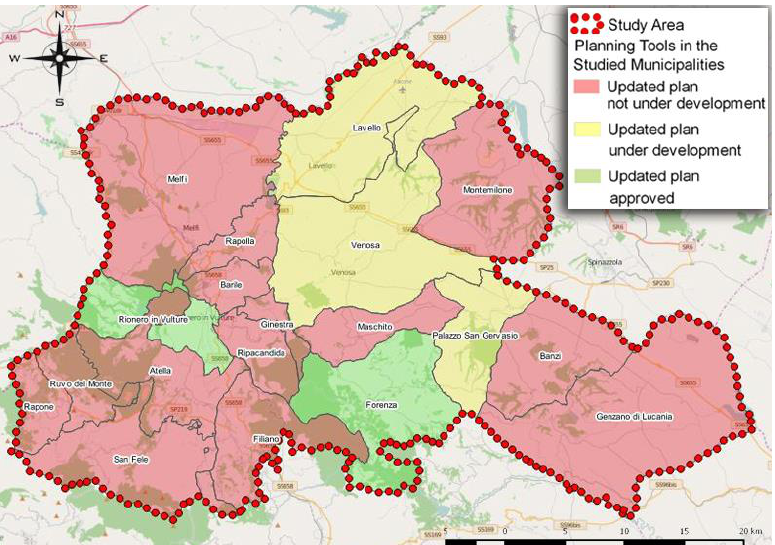
Figure 11. Current land use zoning regulation.